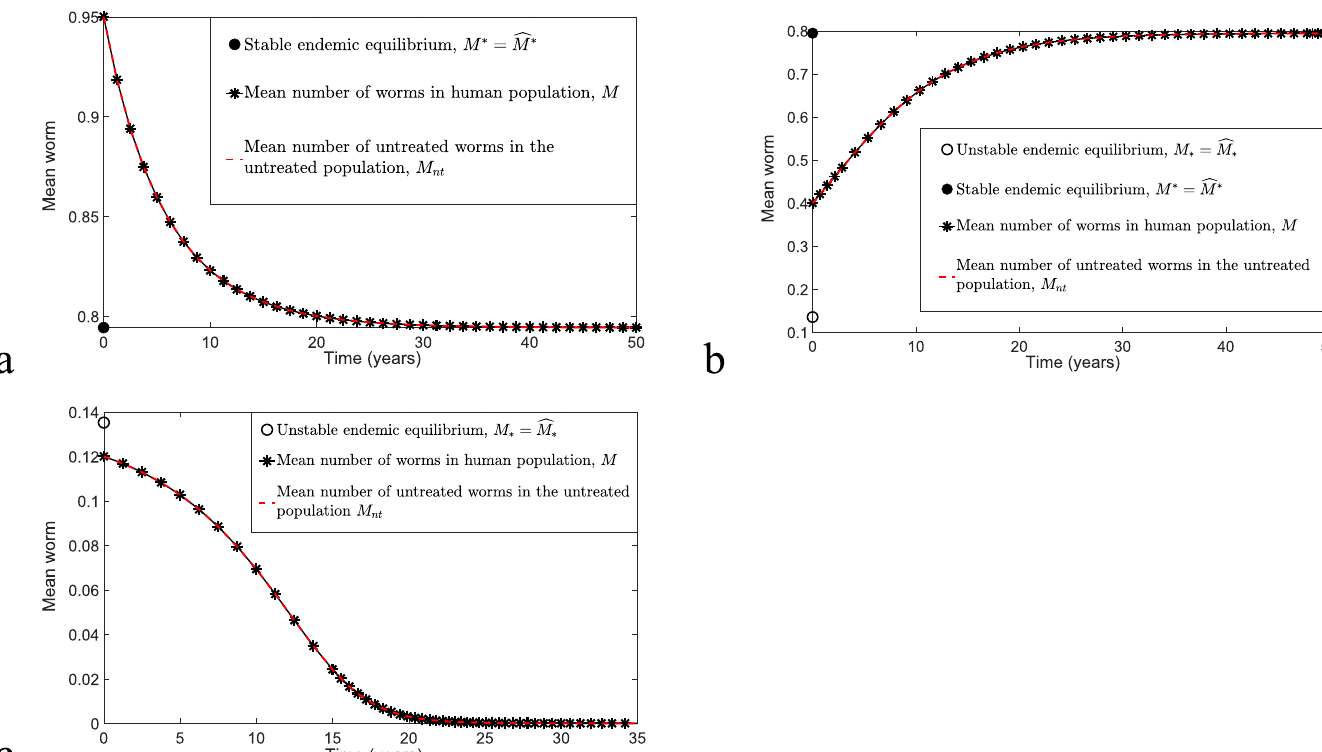
Fig 6. The comparison of models (3) and (9) when no control strategy has been applied. Both models have the same outcomes for arbitrary initial points, R 0 = 2 and k = 0.05. (a) M 0 > M � and M